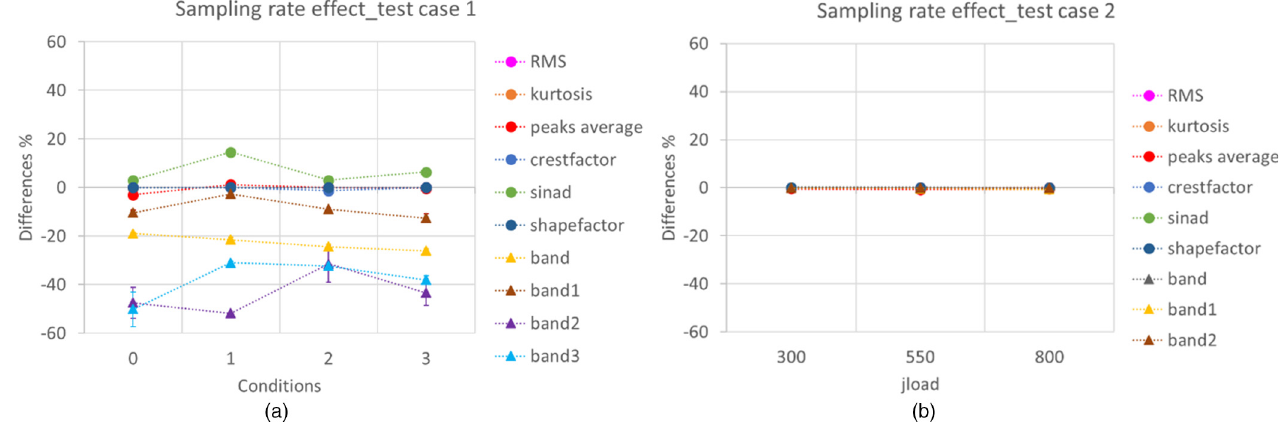
Fig. 6. Effect of the sampling rate on features for CM, in cases 1 (a) and 2 (b).